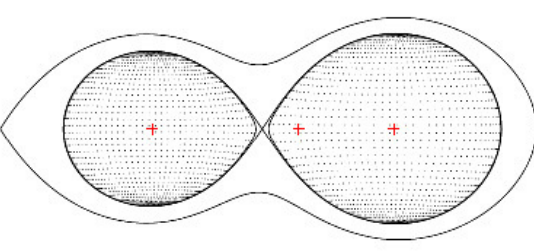
Fig. 5 Roche lobe configuration of IK